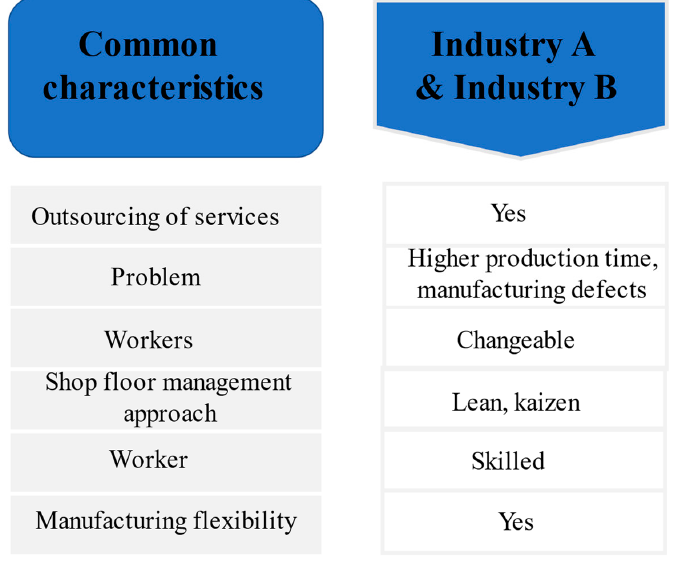
Figure 4. Description of common characteristics in both industries.